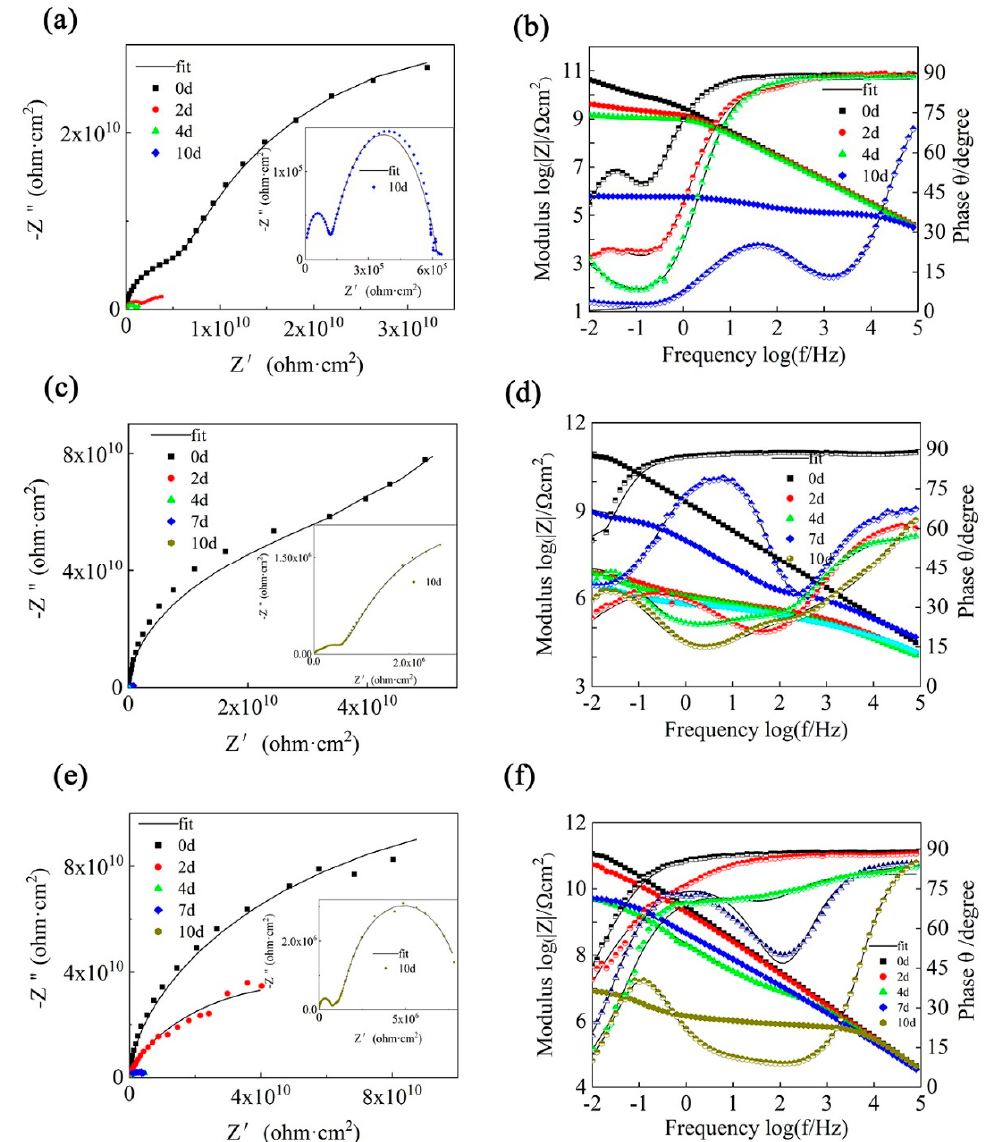
Figure 11. ( a , c , e ) Bode and ( b , d , f ) Nyquist diagrams; ( a , b ) the EP coating, ( c , d ) GO 1 coating, and ( e , f ) SiC 1 coating at different immersion times in 3.5 wt % NaCl solution.